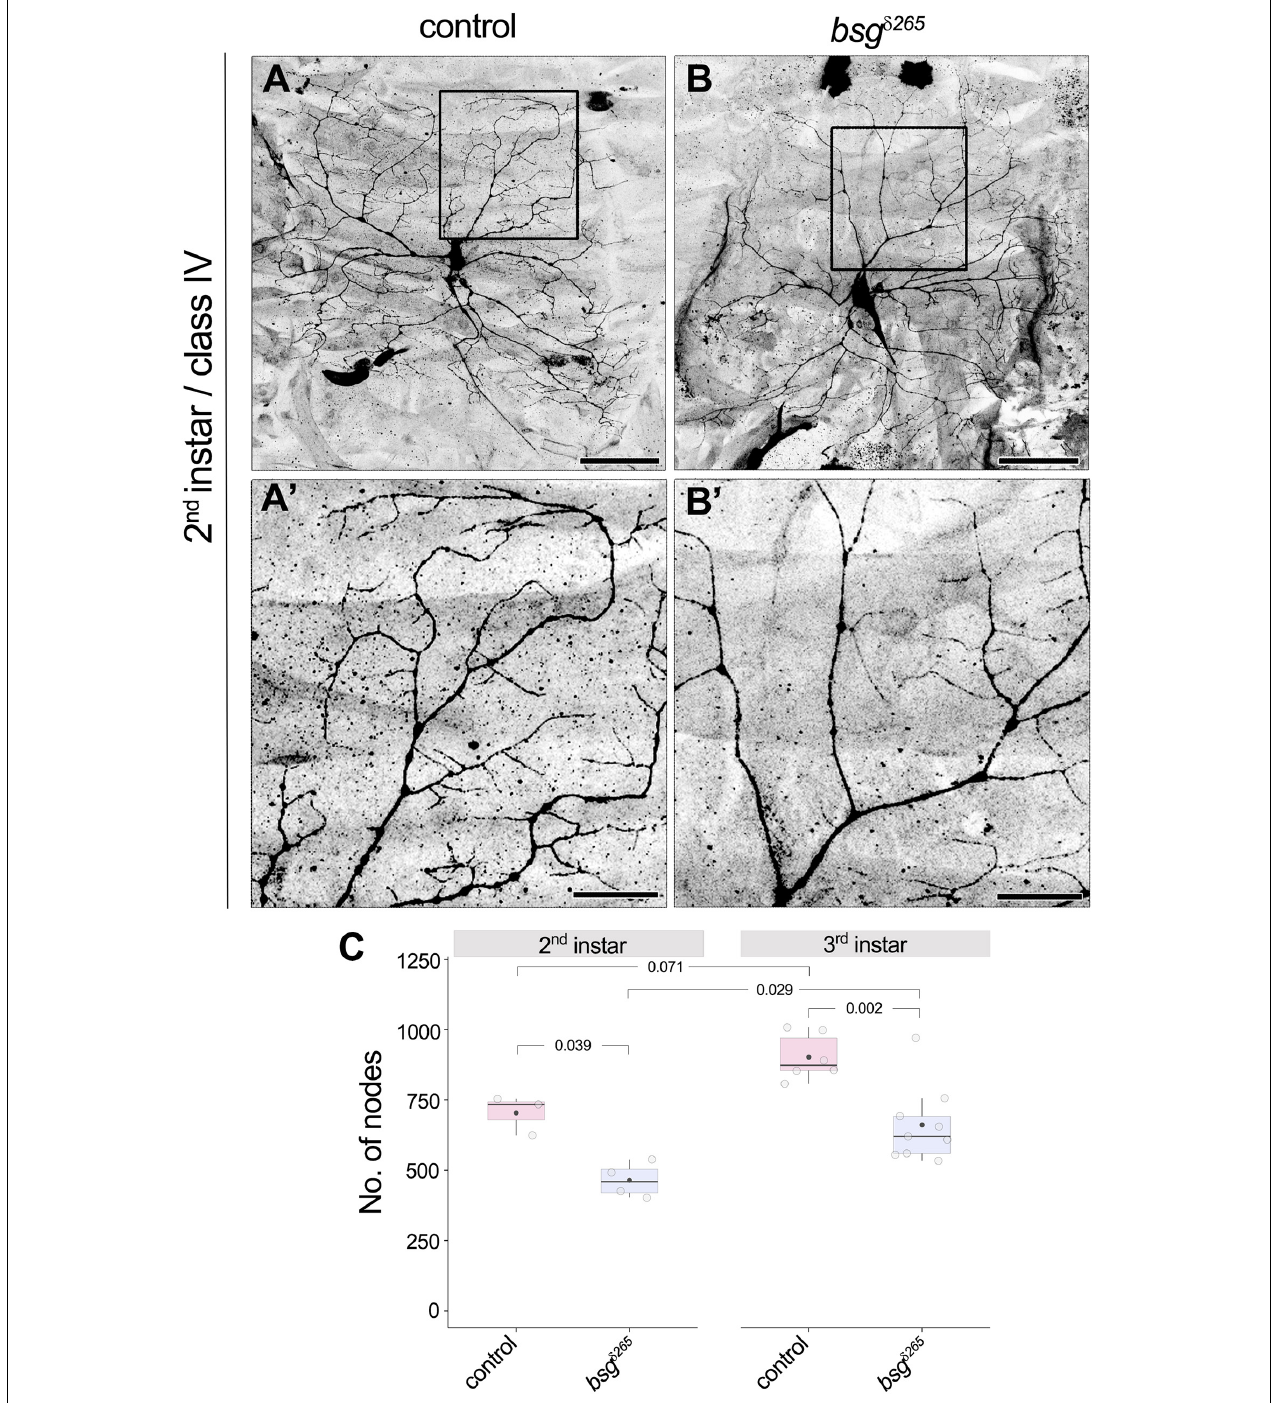
FIGURE 5 | Developmental defect in branch elaboration contributes to formation of aberrant dendritic arbors in bsg - / - class IV neurons. Comparison of dendrites of control (A,A’) and bsg δ 265 class IV MARCM clones (B,B’) at late second instar stage revealed significantly fewer branches in the latter group of neurons (C) , indicating that inadequate branch elaboration during development contributes to the phenotype observed at late third instar stage. Insets (A’) and (B’) show magnified views of the boxes marked in (A) and (B) , respectively. The number of nodes in neurons of third instar larvae is also shown for comparison in (C) . As in control neurons, significant increase in branching occurred between the second and third instar stages in bsg - / - class IV neurons (C) , which indicates that dendrite growth and branching are not completely halted upon loss of Basigin. Scale bars, 50 µ m in (A,B) and 20 µ m in (A’,B’) . p values are indicated for Tukey’s HSD conducted following two-way ANOVA with genotype and developmental stage as independent categorical factors ( p = 0.00007 and 0.00073, respectively).